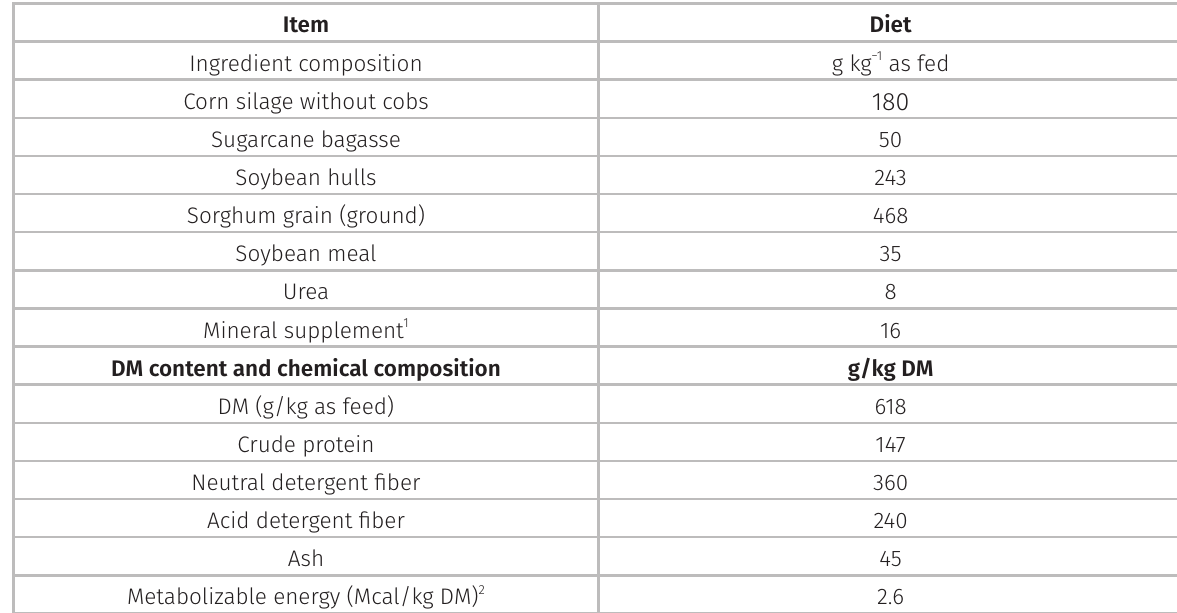
Table I. Composition and nutrient content of experimental diet. Item Diet Ingredient composition g kg −1 as